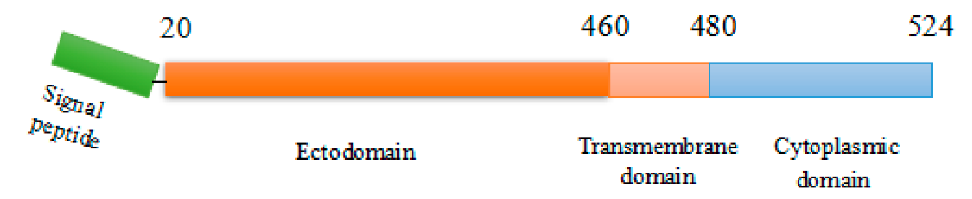
Figure 2. Domain structure of full-length G protein.